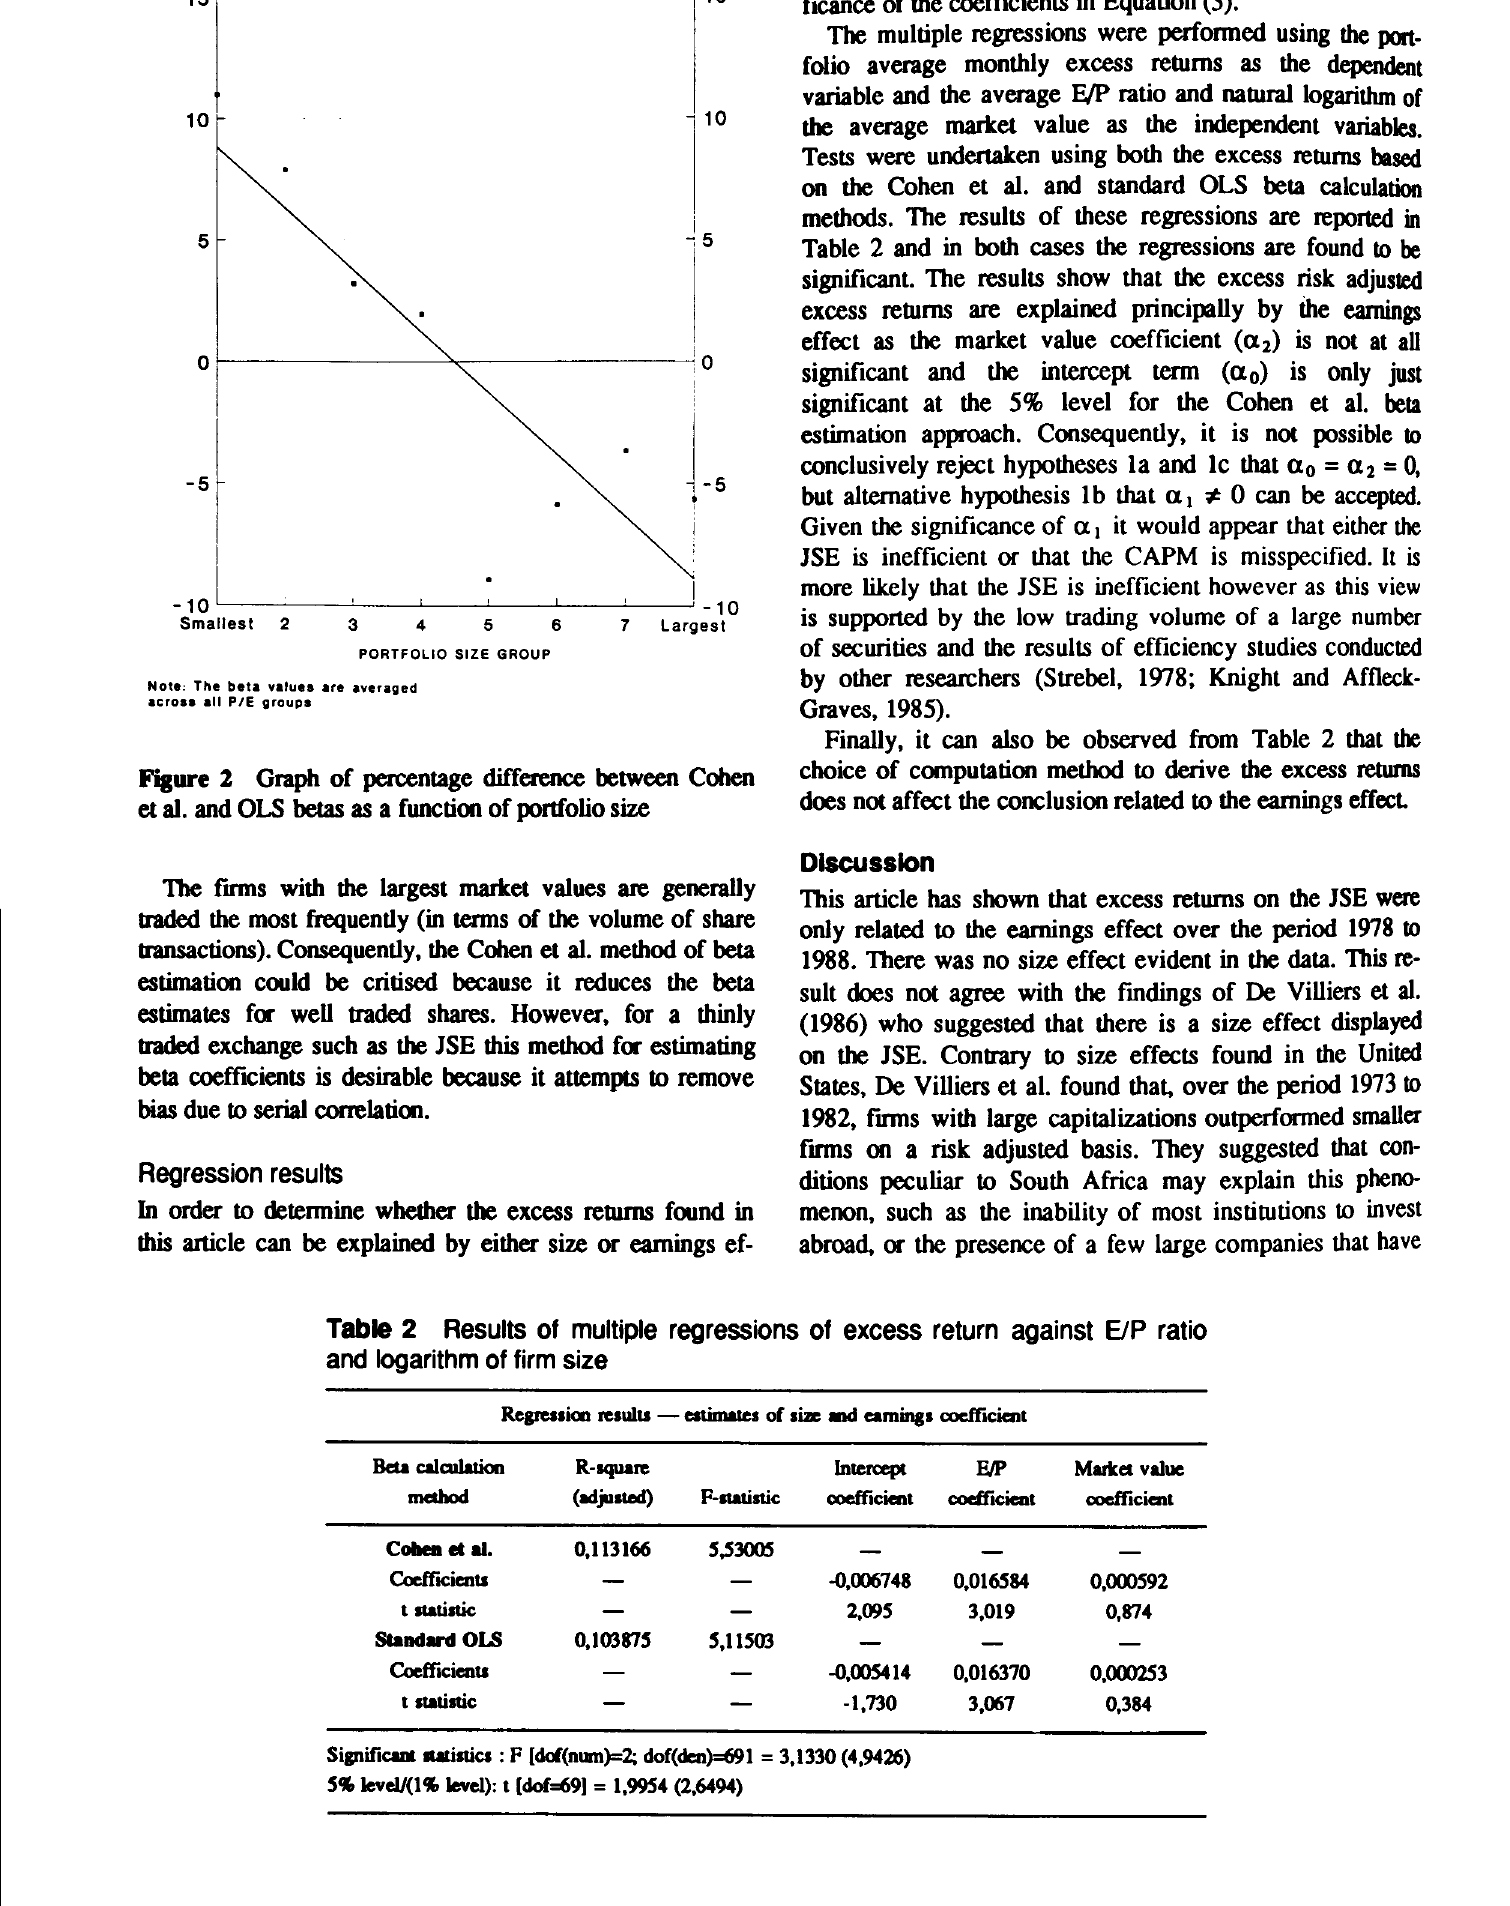
Results of multiple regressions of excess return against E/P ratio and logarithm of firm size Regrea1ioo resulu - eatimales of si& and earnings